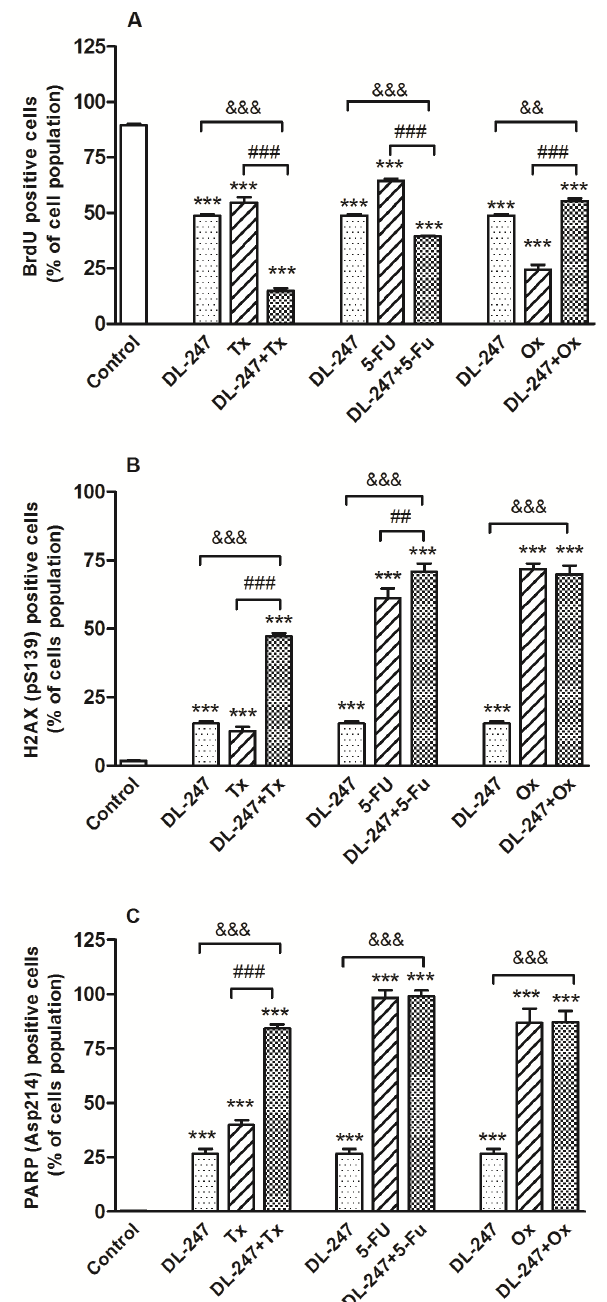
Figure 8. Combined e ff ect of DL-247 (1.15 µ M) and 5-FU (200 µ M), Tx (9 nM) or Ox (8.5 µ M) on ( A ) inhibition of cell proliferation (BrdU test), ( B ) induction of DNA damage (H2AX test) and ( C ) induction of apoptosis (PAPR test) in HL-60 cells. Cells were co-incubated with DL-247 and an anticancer drug for 24 h. Then, BrdU was added to the culture medium, and cells were incubated for additional 8 h. The cells were stained with fluorochrome-labeled anti-BrdU, anti-cleaved PARP (Asp214) and anti-H2AX (pS139) antibodies for 20 min at room temperature and analyzed by flow cytometry. ( A – C ): Data are presented as mean ± SEM of three independent experiments. Statistical significance was assessed using one-way ANOVA and a post hoc multiple comparison Student–Newman–Keuls test. *** p < 0.001 vs. control; && p < 0.01, &&& p < 0.001 vs. DL-247; ## p < 0.01, ### p < 0.001 vs. respective anticancer